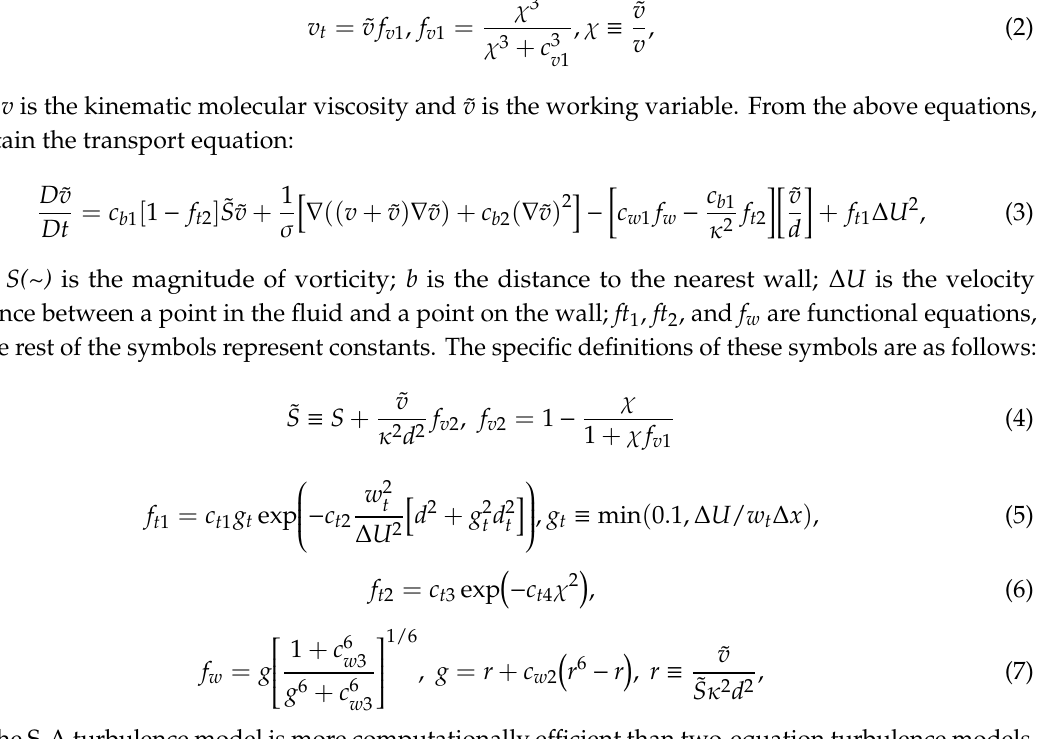
Figure 2. Computational domain. Figure 3. Computational domain mesh. The grid around the hydrofoil is shown in Figure 3. Two mesh types were used in the computational domain, namely trimmed and prism layer meshes. The trimmed mesh was the primary type of mesh used in the fluid region. This part of the mesh consisted of quadrilateral elements parallel to the inflow; this configuration reduces truncation errors in the calculation. Prism layer meshes were used to generate the boundary layers. A 3c × 2c refined region was set up around the hydrofoil to refine the flows around it, and the mesh size in this region was 5% of that of the unrefined region. The computational domain contained a total of 2,495,989 mesh elements.